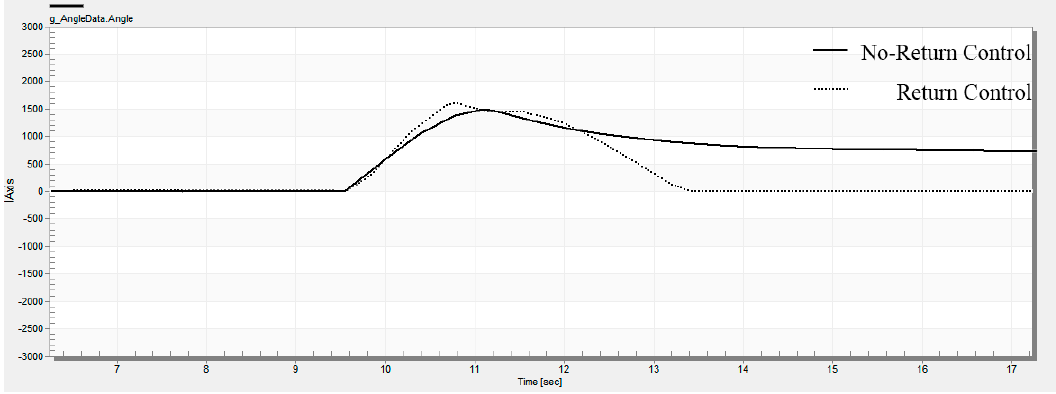
Figure 10. RTC curves of the steering wheel.